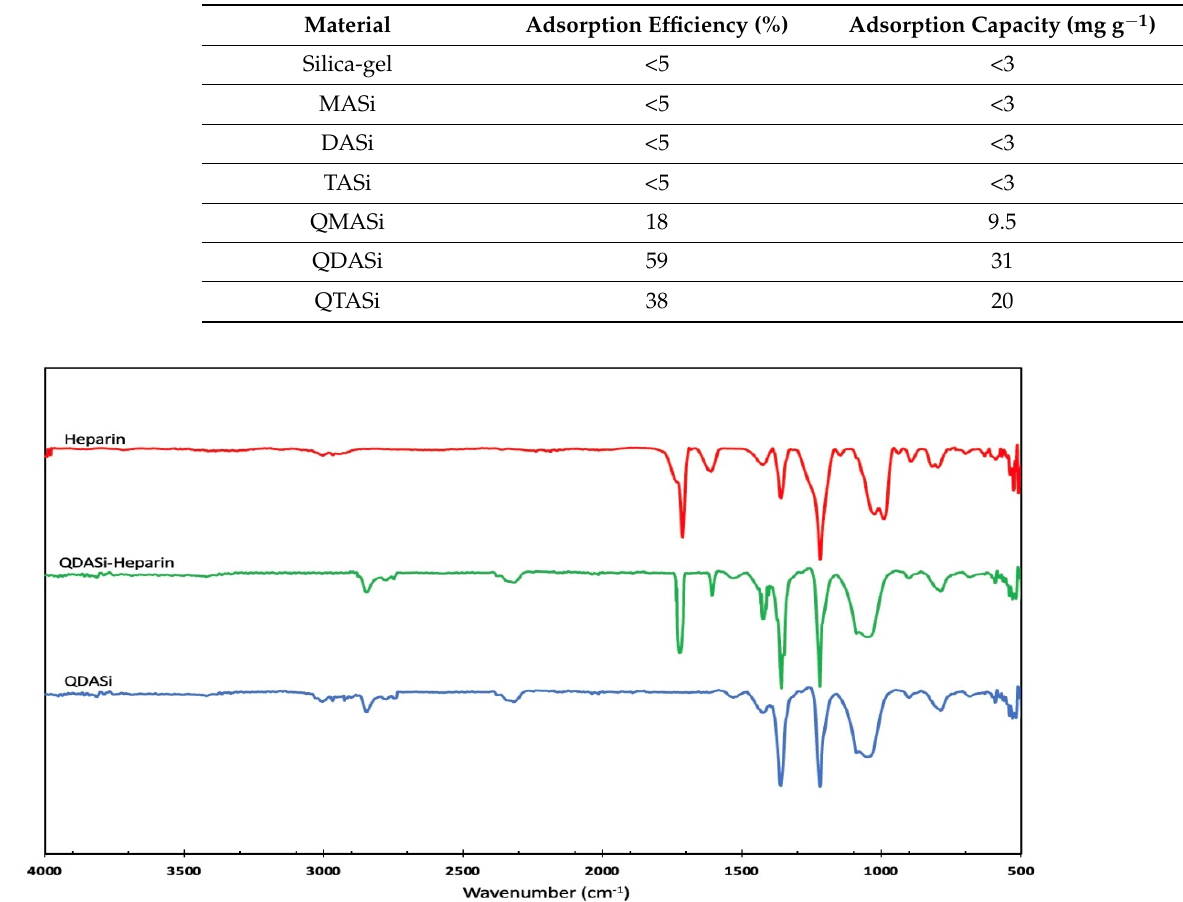
Figure 2. FTIR spectra of the standard heparin, QDASi, and pre-adsorbed heparin on the QDASi.